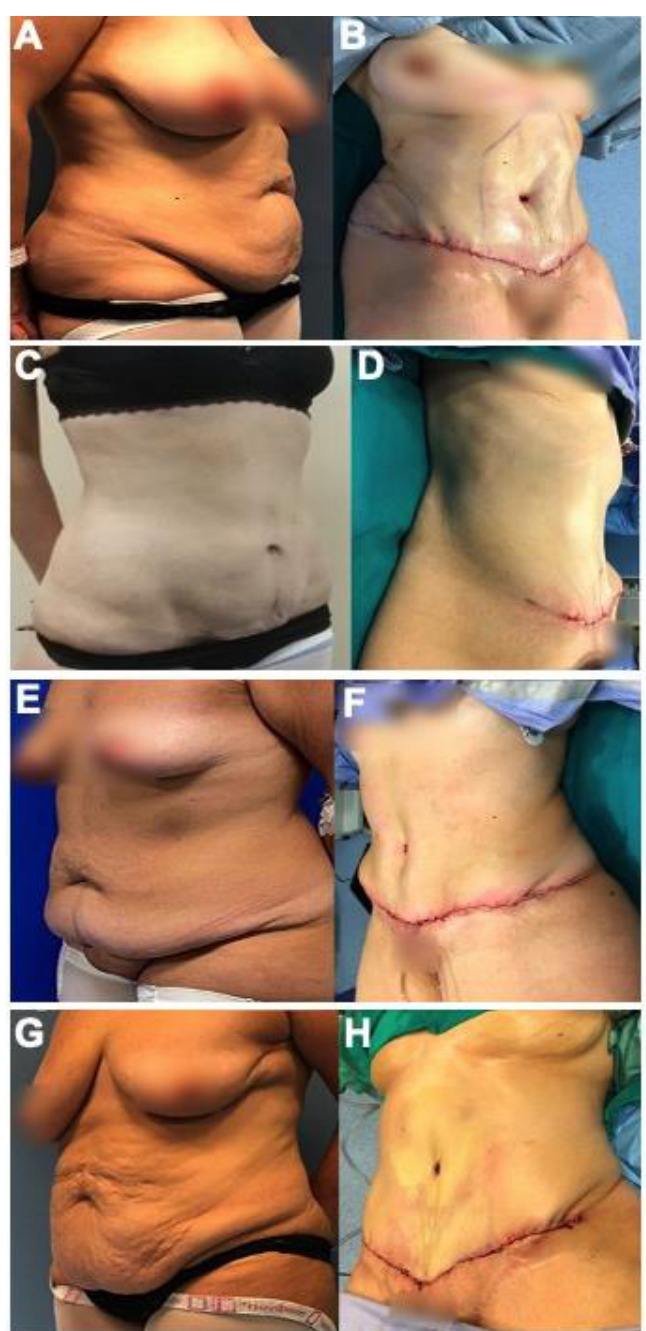
Figure 3. AP-lateral view: ( A , C , E , G ) and after ( B , D , F , H ) photos of the patients underwent lipo-abdominoplasty and high superior tension using radiofrequencies energy for dissection. ( A , B ): Female, 44 years old, submitted to traditional abdominoplasty after gastric mini-bypass 41 kg of weight loss. ( C , D ): Female, 29 years old, abdominoplasty after diet and 18 kg of weight loss. ( E , F ): Female, 40 years old, abdominoplasty after sleeve-gastrectomy and 55 kg of weight loss. ( G , H ): Female, 59 years old, abdominoplasty after mini-bypass and 45 kg of weight loss.